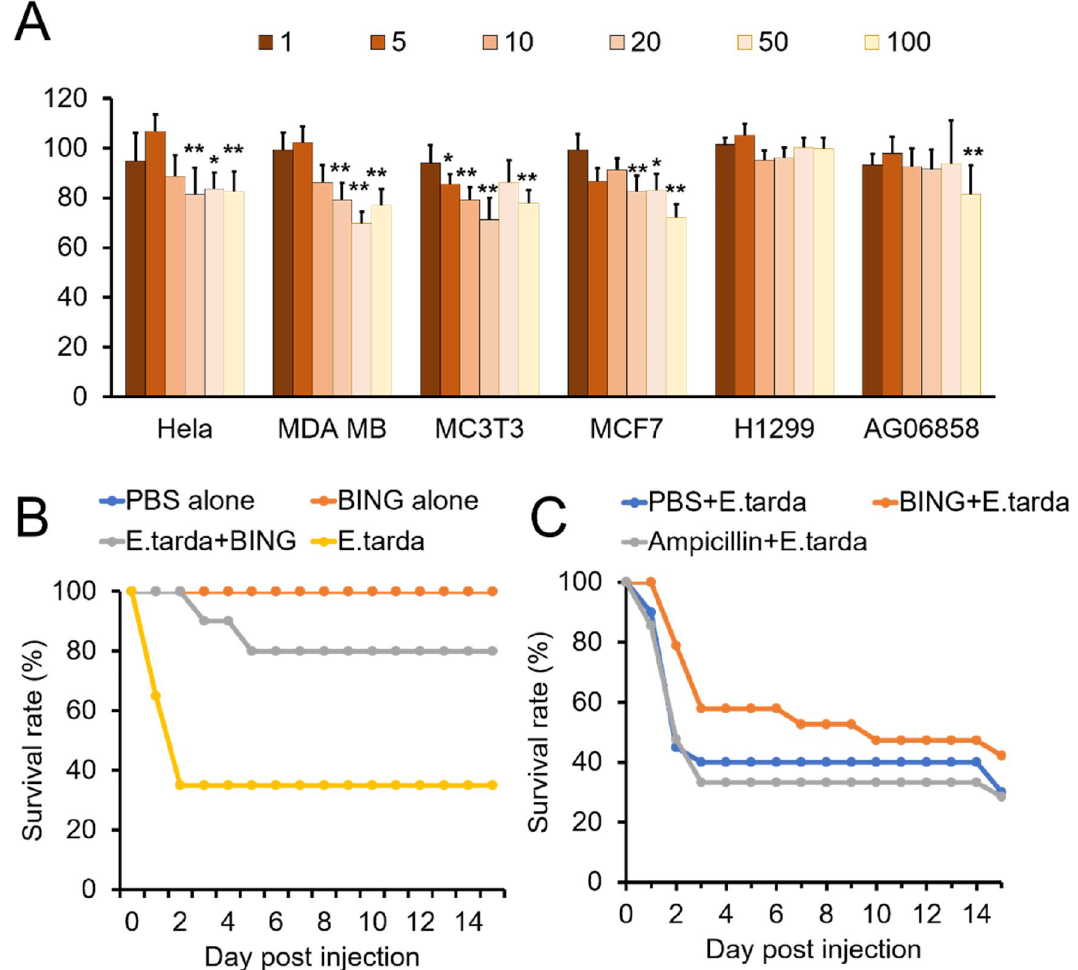
Figure 8. Effect of BING on mammalian cells and medaka fish. ( A ) Effect of BING on the viability of cultured mammalian cells, incubated for 48 h in the presence of BING at different concentrations (µg/mL), as determined by MTT assay. Cell viabilities are represented as peptide treated cell numbers over medium-only control. Statistically significant difference as compared to controls (* p < 0.05, ** p < 0.01, n = 4). ( B , C ) Survival of medaka fish injected with a lethal dose of E. tarda (10 4 CFU/fish) with or without AMP and antibiotic. ( B ) Co-injection experiment: BING only, injected with 1 µL of BING (1 mg/mL); E. tarda + BING: injected with 1 µL of E. tarda (10 7 CFU/mL) and BING (1 mg/mL) mixture; E. tarda alone (1 µL of E. tarda : 10 7 CFU/mL). ( C ) Sequential injection experiment: 1 µL of BING (2 mg/mL), Ampicillin (2.1 mg/mL) or PBS injection followed by E. tarda injection after two hours (1 µL of E. tarda : 10 7 CFU/mL). 20 fish per group. Log-rank (Mantel-Cox) test was applied for the comparison of survival curves (* p < 0.05; ** p <